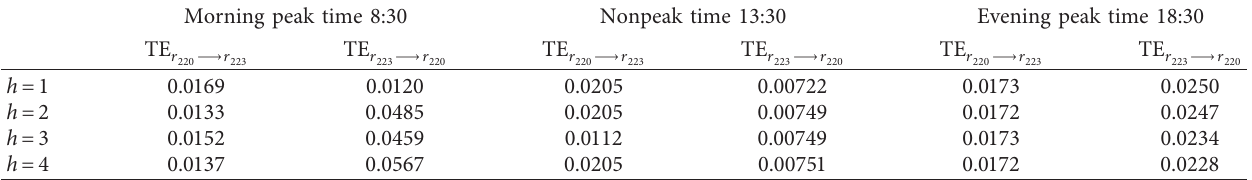
Table 1: Transfer entropy values in different time